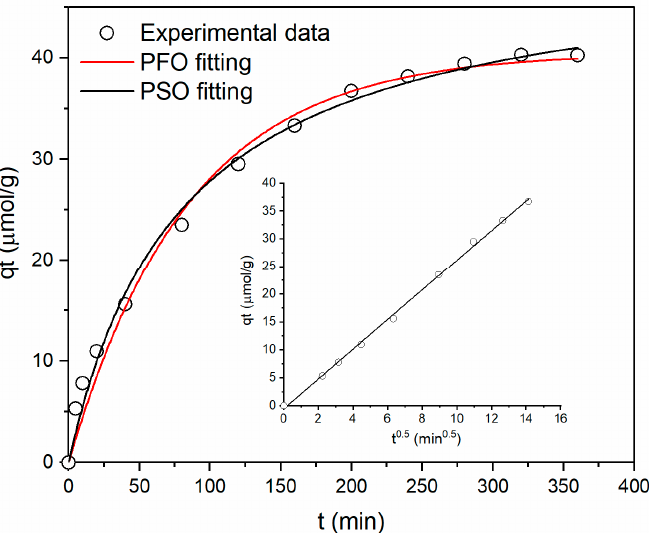
Figure 6. Adsorption kinetics in a dispersion of 2.0 g of FeOH-Vt in 200 mL of an initial 4.84 × 10 2 μ mol·L − 1 phosphate solution (15.0 mg·L − 1 in P) fitted to the PFO and PSO kinetic models. The inset shows the data fitting to the ID model. Table 1. Kinetic parameters fitted by PFO, PSO and ID models by NLR analysis.